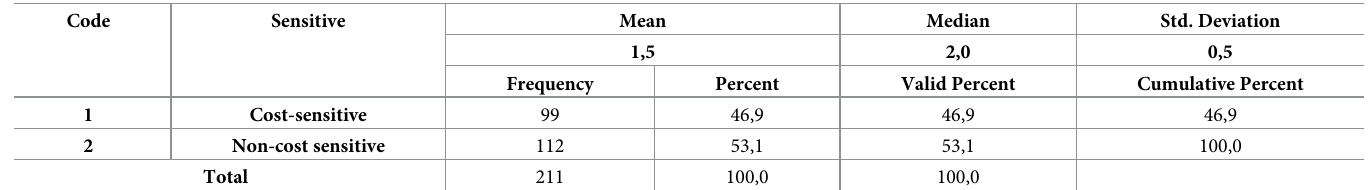
Table 8. Internet costs